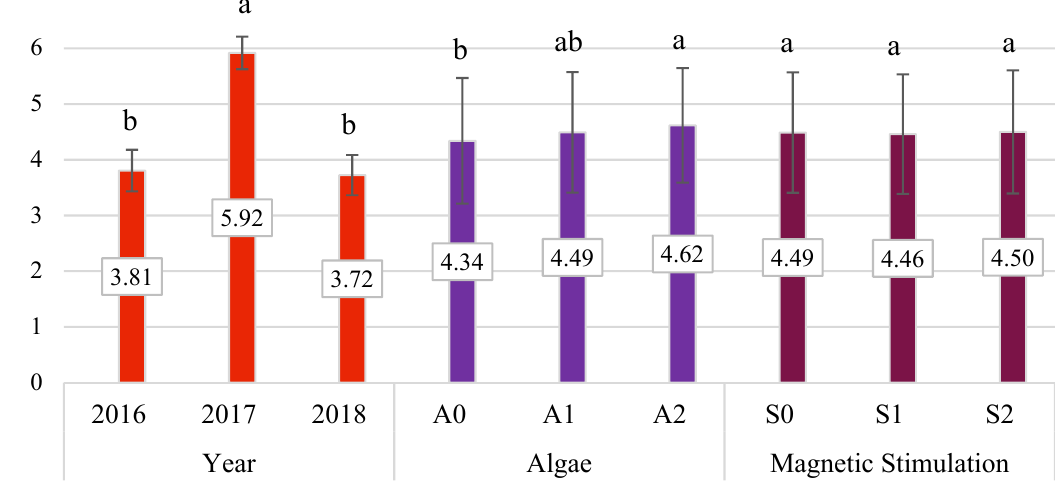
Figure 9. Effect of the algae dose and the MF exposure dose on oat grain yield (t · h − 1 ) from 2016 to 2018. According to Tukey’s HSD (honest significant difference) test, the means marked with the same letter were not significantly different at α ≤ 0.05.